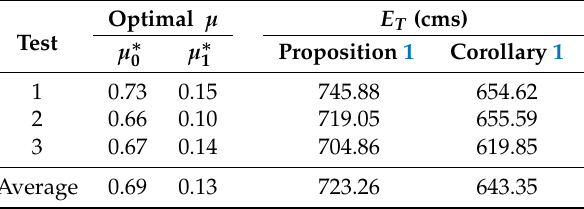
Figure 8. Optimal parameter of µ from Corollary 1 when φ = 1 for three tests. Table 2. Analysis of localization error and optimal values of µ for Proposition 1 and Corollary